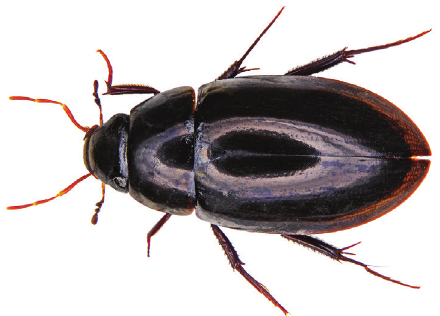
Figure 26. Sternolophus solieri Laporte, 1840 9.9 mm, iSimangaliso Wetland Park, False Bay (site 27), January 2015 DT Bilton, MS Bird & R Perissinotto